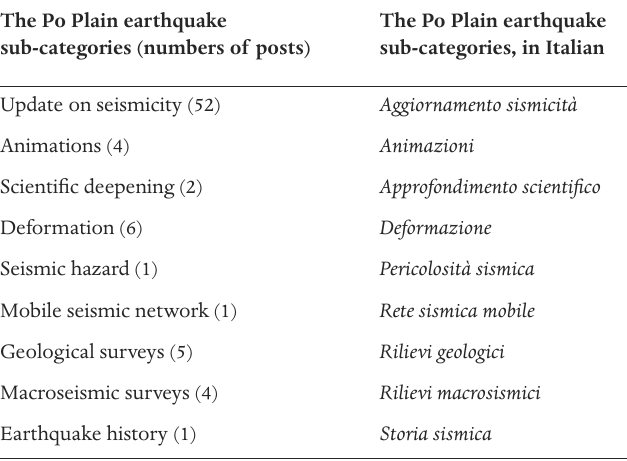
Table 1. The nine subcategories of 'The Po Plain earthquakes in Emilia' ( I terremoti della Pianura Padana Emiliana ) INGVterremoti